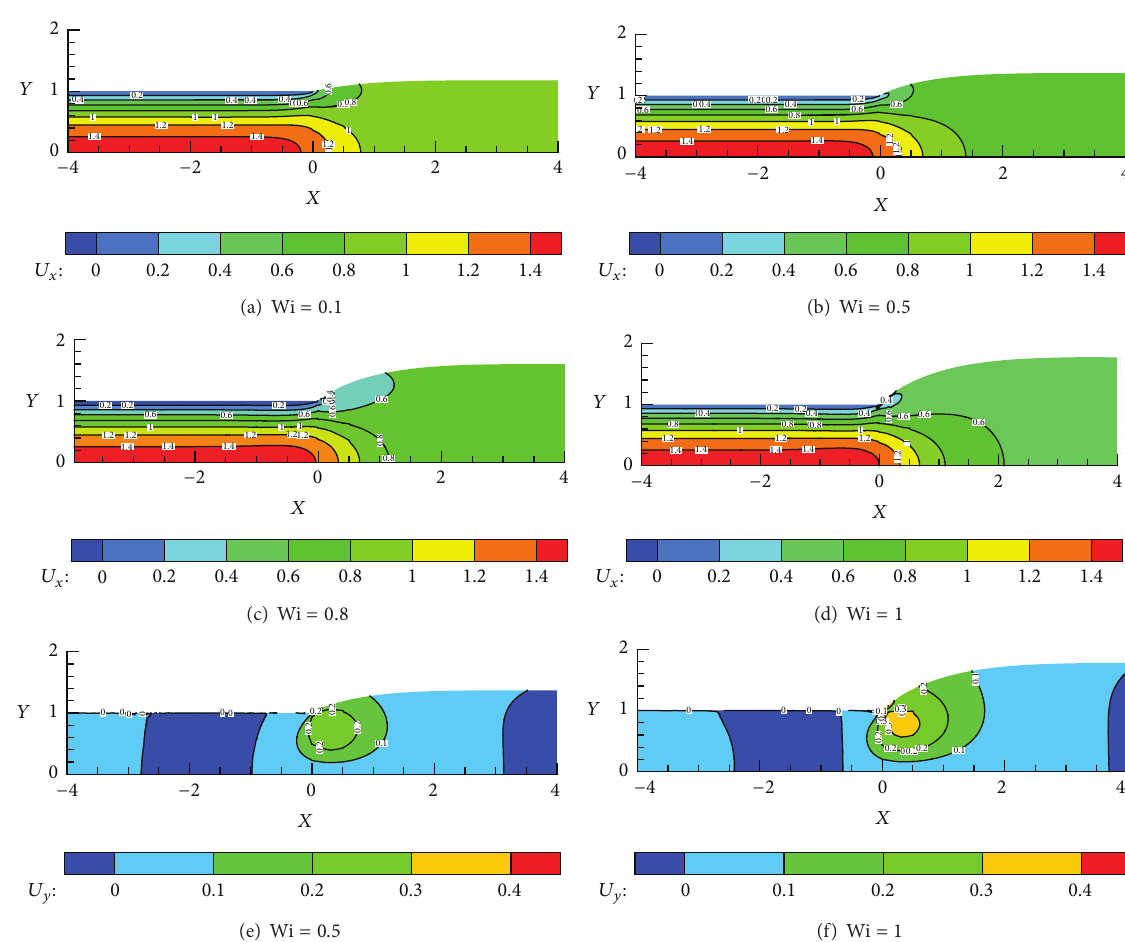
Figure 6: Contour plots of velocity components 𝑈 𝑥 (a)–(d) and 𝑈 𝑦 (e)-(f) for a range of Wi.